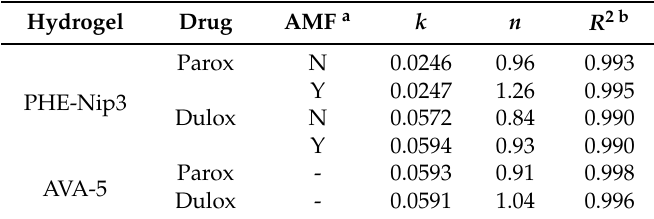
Table 2. Parameters of the empirical Peppas’s power law expression ( M t / M ° = kt n ) for the release of paroxetine and duloxetine through the hydrogels PHE-Nip3 and AVA-5 in PBS buffer (pH 7.40) with and without AMF stimulations.